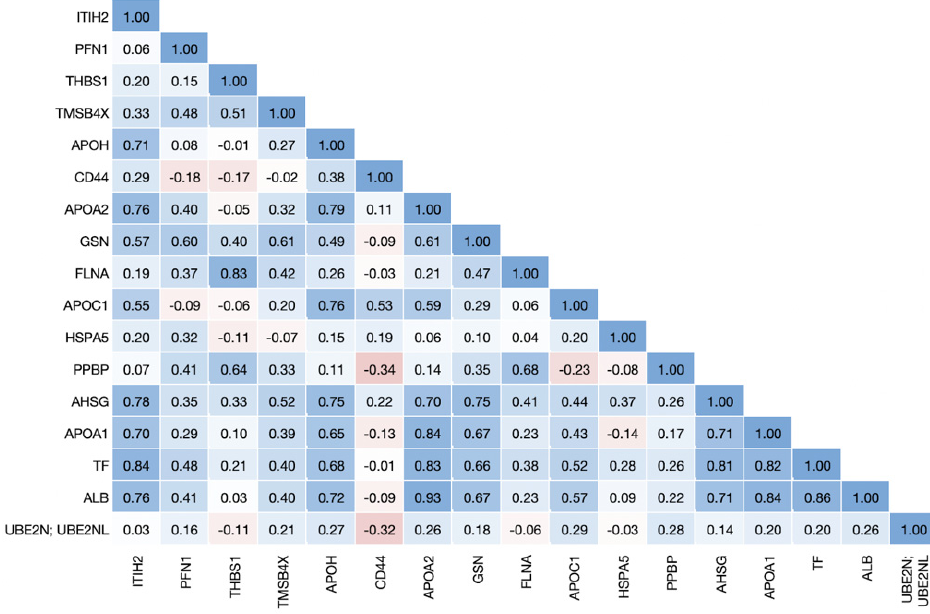
Figure 2. Correlation matrix of proteins downregulated in COVID-19 disease states. Proteins that were downregulated in non-severe and severe COVID-19 in the [9] dataset or downregulated in COVID-19 in the [8] dataset were identified in the erythrocyte dataset and Pearson correlations were calculated among all